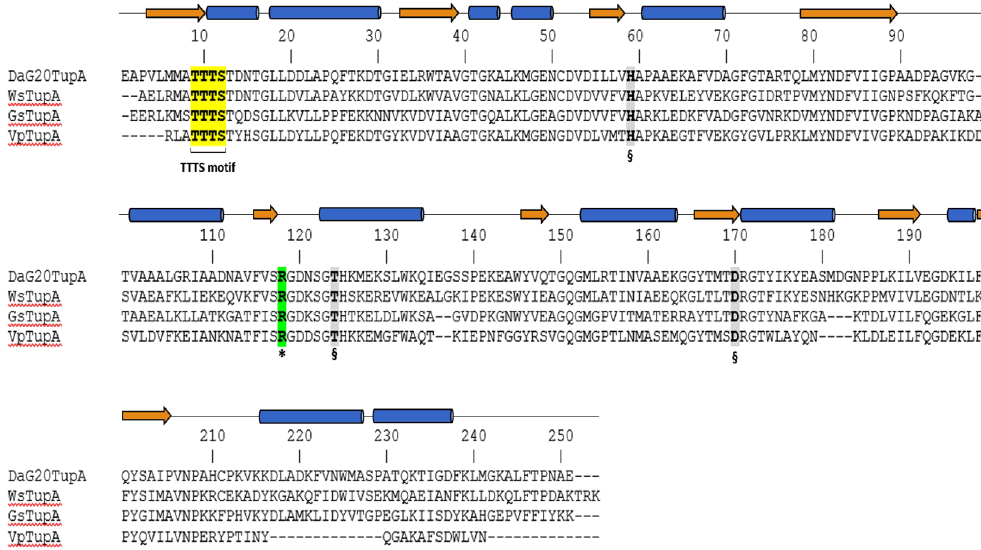
Figure 2. Multiple sequence alignment of mature TupA proteins from different organisms. DaG20TupA - TupA from Desulfovibrio alaskensis G20 (locus tag Dde_0234); WsTupA - TupA from Wolinella succinogenes (locus tag WS1370 ) ; GsTupA - TupA from Geobacter sulfurreducens (locus tag GSU2700) and VsTupA - TupA from Vibrio parahaemolyticus (locus tag VP1501). Important ( * ) and putative ( § ) residues involved in oxyanion